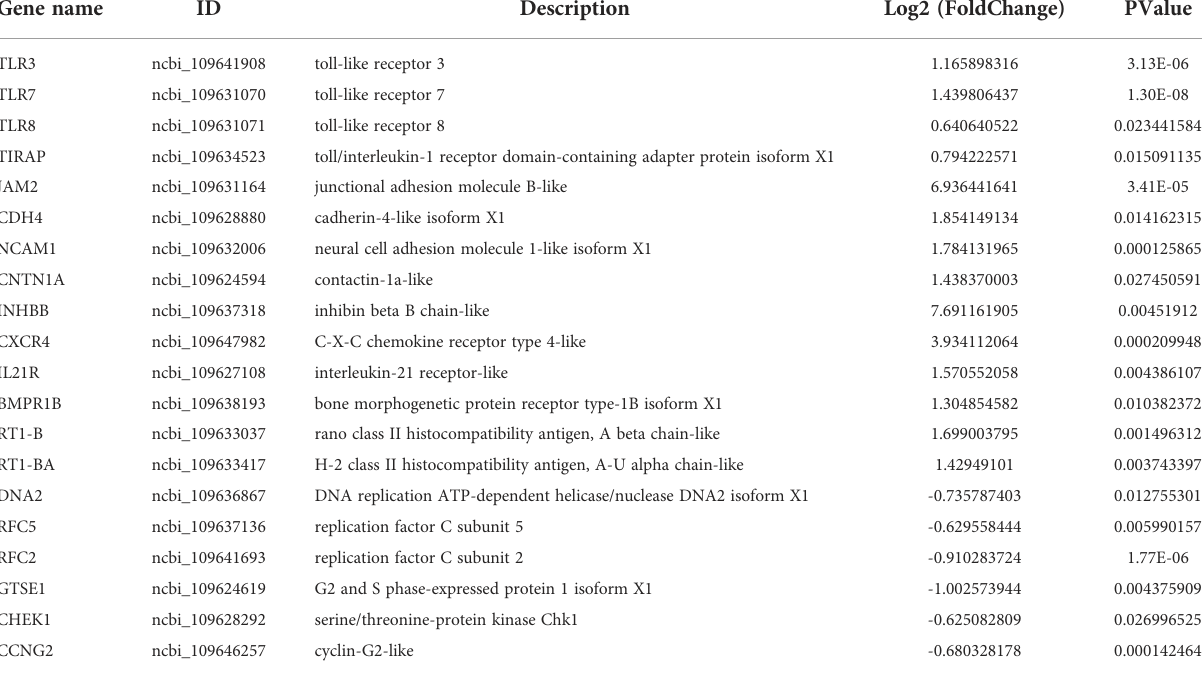
TABLE 5 Summary of immune-related genes in the inactivated vaccine group compared to the PBS group at 1 st post challenge